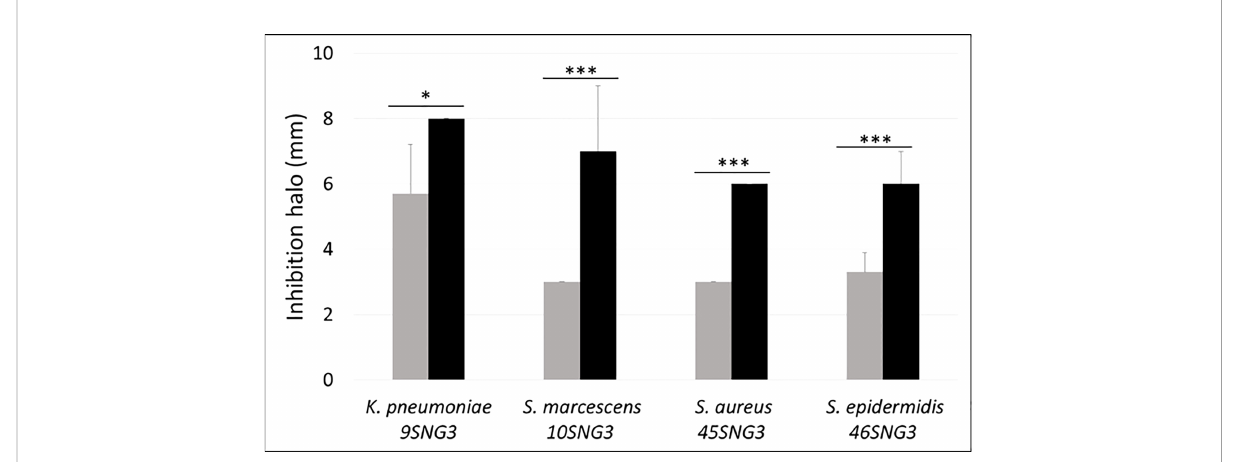
FIGURE 1 Antimicrobial activity (mm) of L. salivarius 20SNG2 (black bars) and L. reuteri 7SNG3 (grey bars) against the selected strains of S. marcescens , K. pneumoniae , S. aureus and S. epidermidis . Asterisks show statistical differences between the LAB effect on these strains: * (p < 0.05), and *** (p <